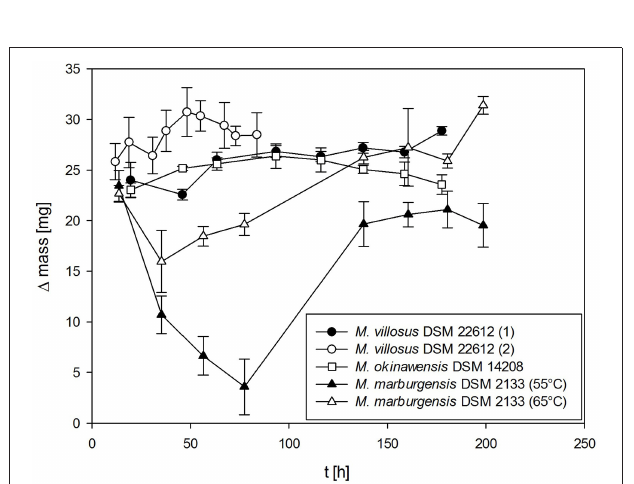
FIGURE 5 | Total cumulative mass gain for M. villosus , M. okinawensis and M. marburgensis . For M. villosus an experiment with a daily gassing event [marked M. villosus (1)] and one experiment with two gassing events per day [marked as M. villosus (2)] were performed. For M. marburgensis cultivations at 55 ◦ C and at 65 ◦ C were performed. Negative controls are not